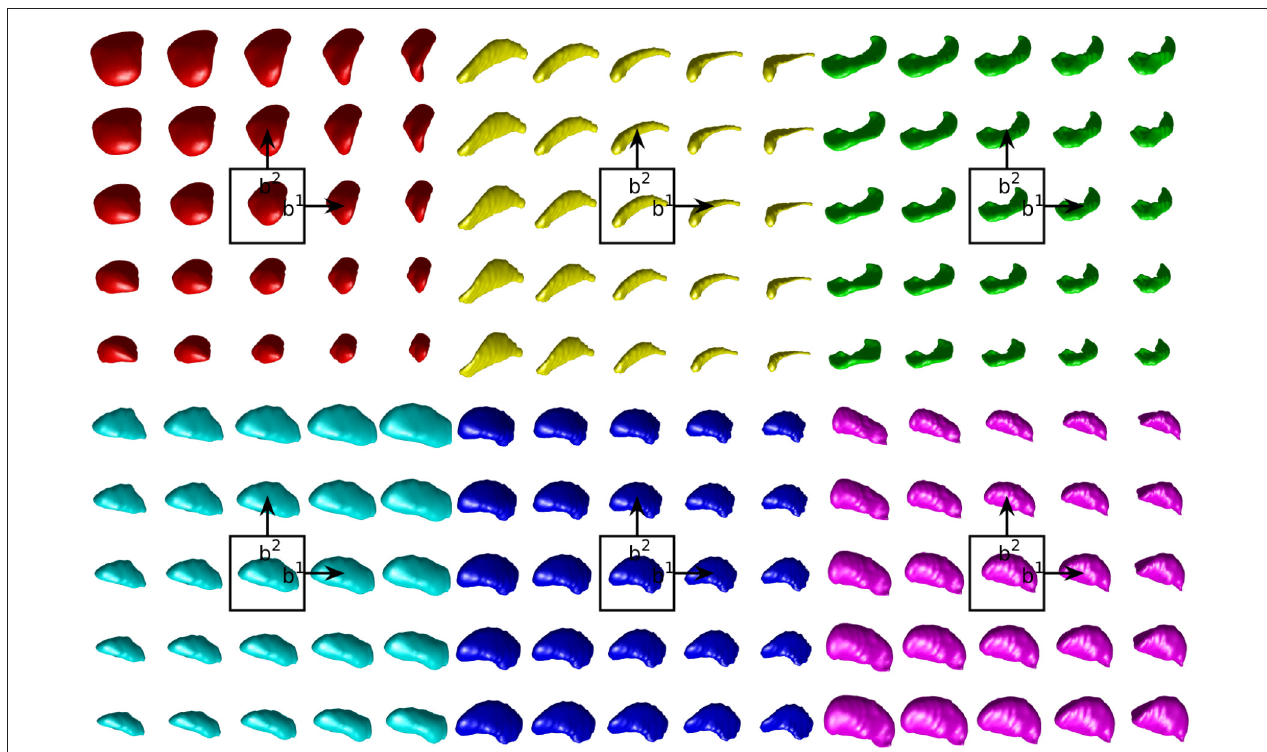
FIGURE 4 | Examples of the first two modes of variability in our empirical prior for left side structures. The mean shape is shown in the center. Each step to the right (top) moves one standard deviation in the direction of the first (second) mode of variation. In lexicographic order: amygdala, caudate, hippocampus, globus pallidus, putamen,